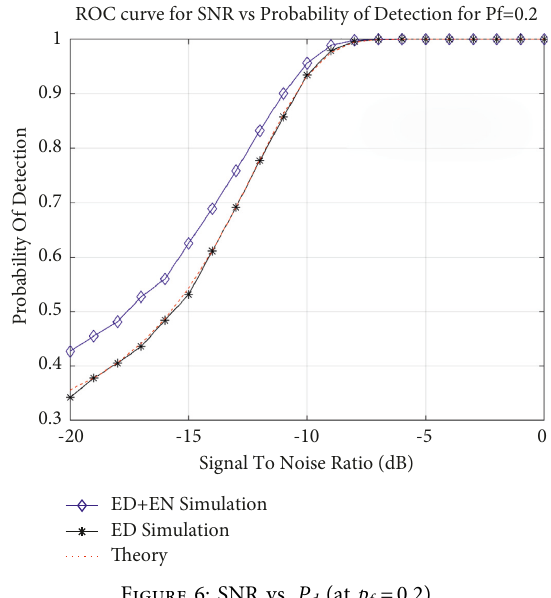
f vs. P d at SNR